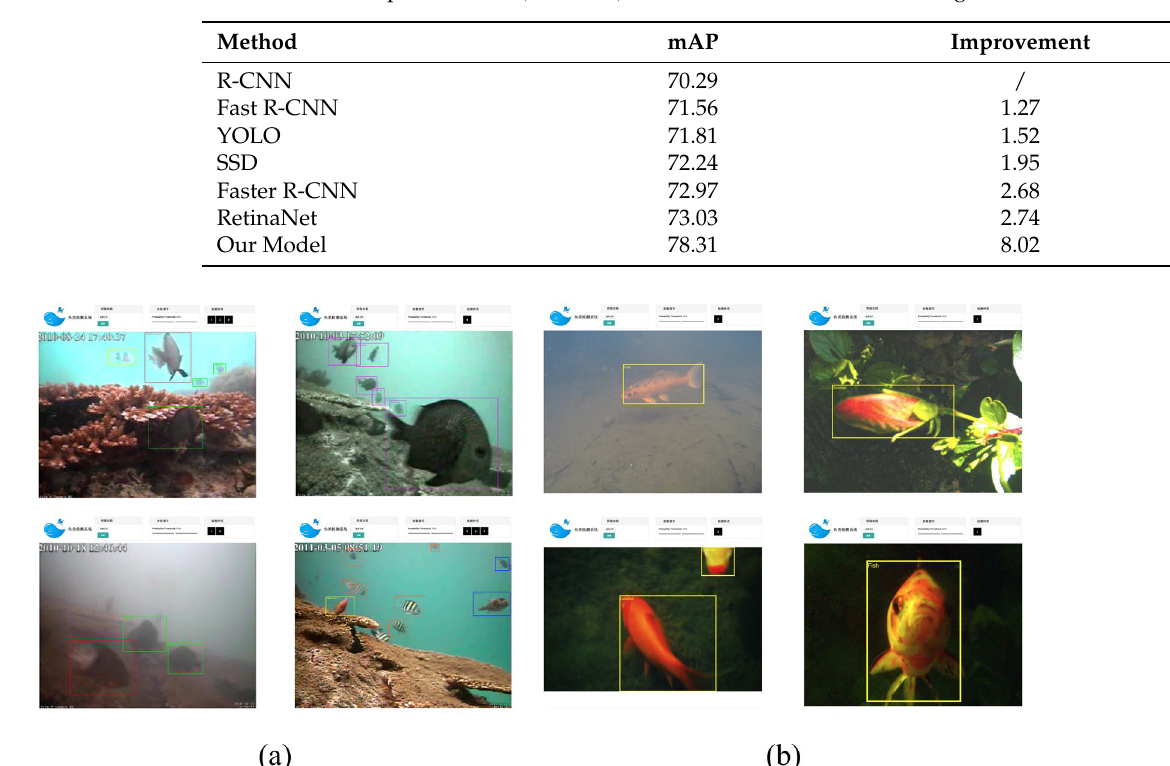
Table 3. Detection performance (Precision) of the seven tested methods using the LifeCLEF test set.